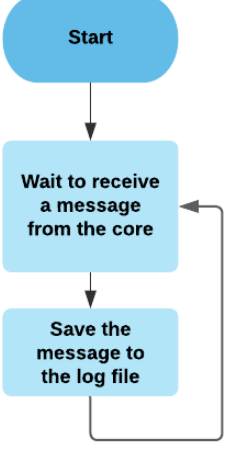
Figure 15. The flowchart of the logger module.